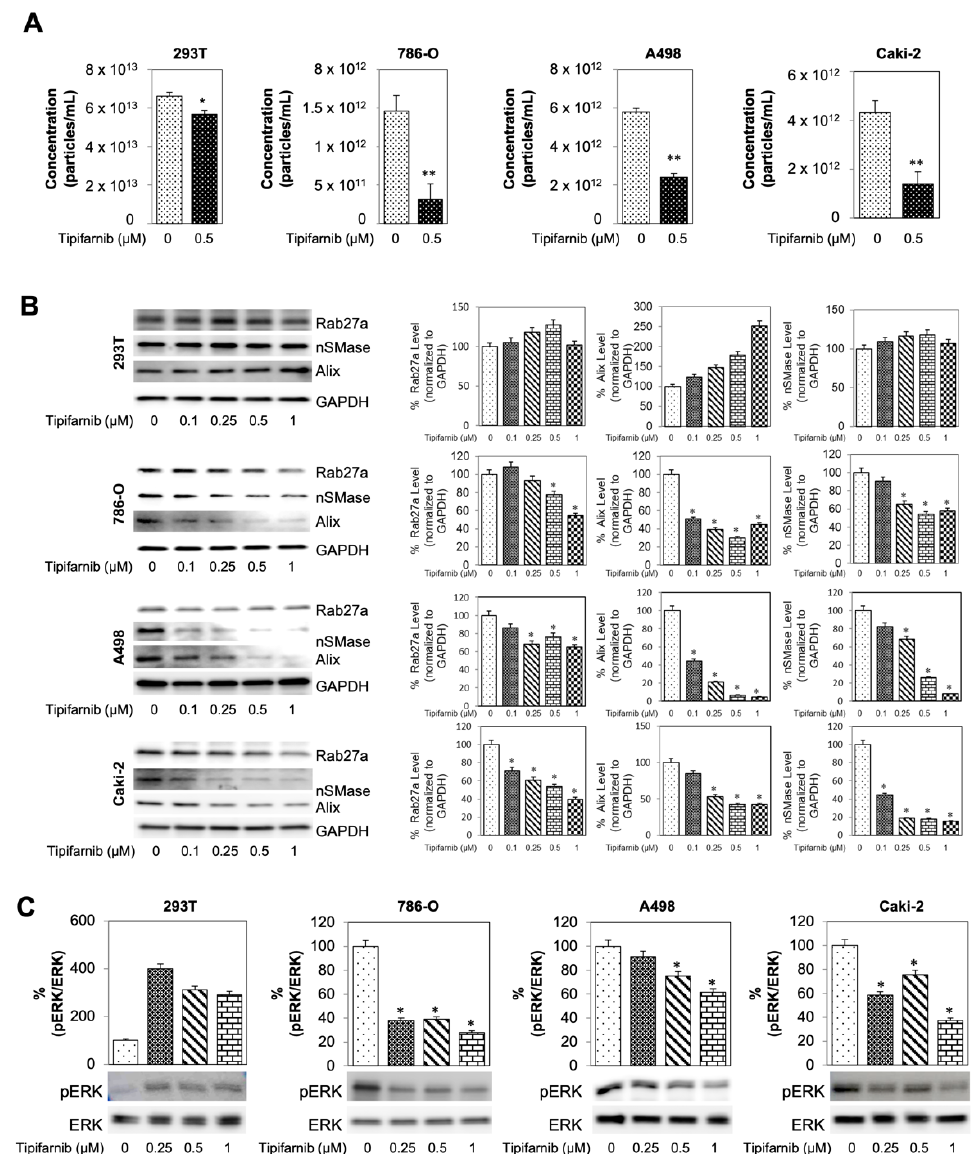
Figure 4. Tipifarnib reduces exosome load in sunitinib-sensitive RCC cell lines. ( A ) Measurement of exosome concentration across sensitive cell lines. After 0.5 uM of tipifarnib 786-O, A498, and Caki-2 displayed a decrease in overall exosome concentration. ( B ) Western blot analysis of exosome biogenesis and secretion markers Rab27a, nSMase, and Alix. All 3 markers display a dose dependent decrease in cancerous cell lines—A498, Caki-2, and 786-0. Either no change or dose dependent increase in these markers was seen in control 293T cells. ( C ) Activated ERK (pERK) to overall ERK ratio across sensitive cell lines. * p < 0.05, ** p < 0.01.